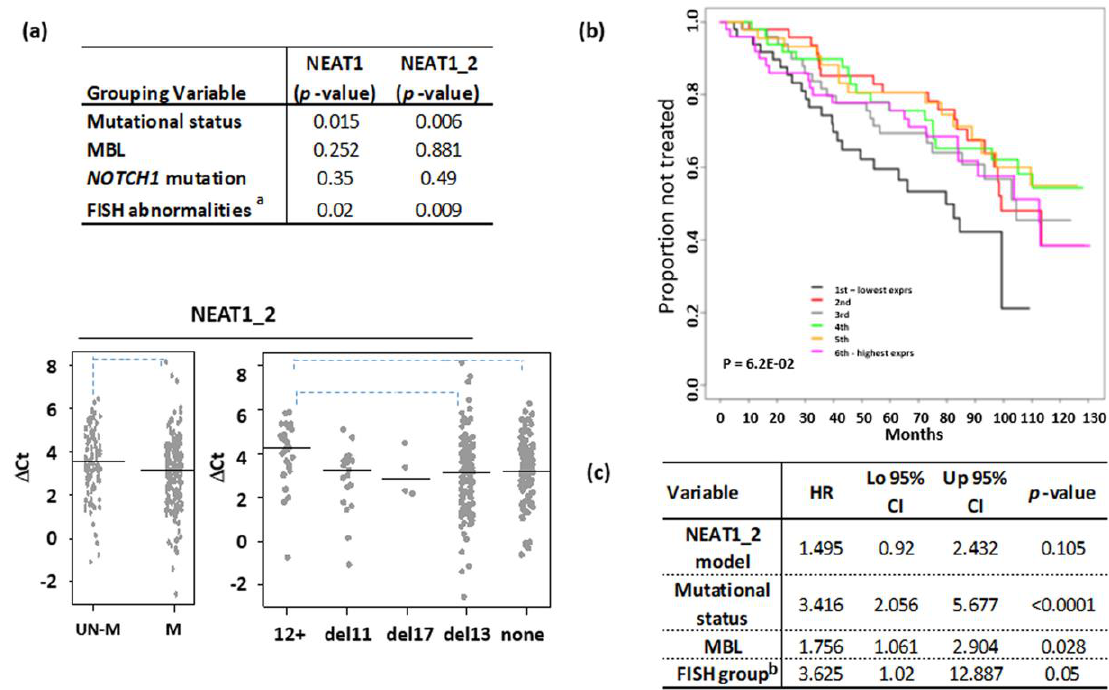
Figure 2. NEAT1 expression level in CLL. ( a ) Wilcoxon test results comparing CLL subgroup defined by the indicated parameter; p -value < 0.01 was considered significant ( a Kruskal-Wallis test). Below, stripchart of NEAT1_2 expression in CLL subgroups defined by mutational IGVH status or the presence of the main chromosomal abnormalities detected by FISH; none = absence of FISH abnormalities (dashed line for p < 0.01, Dunn’s test). ( b ) Kaplan–Meier estimated curves of the six groups defined by NEAT1_2 expression levels. ( c ) Multivariate analysis comparing the NEAT1_2 risk model